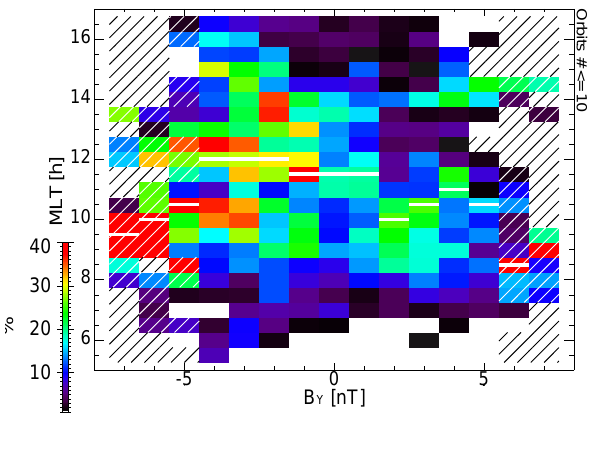
Fig. 5. The cusp longitudinal location as a function of the IMF B Y component.